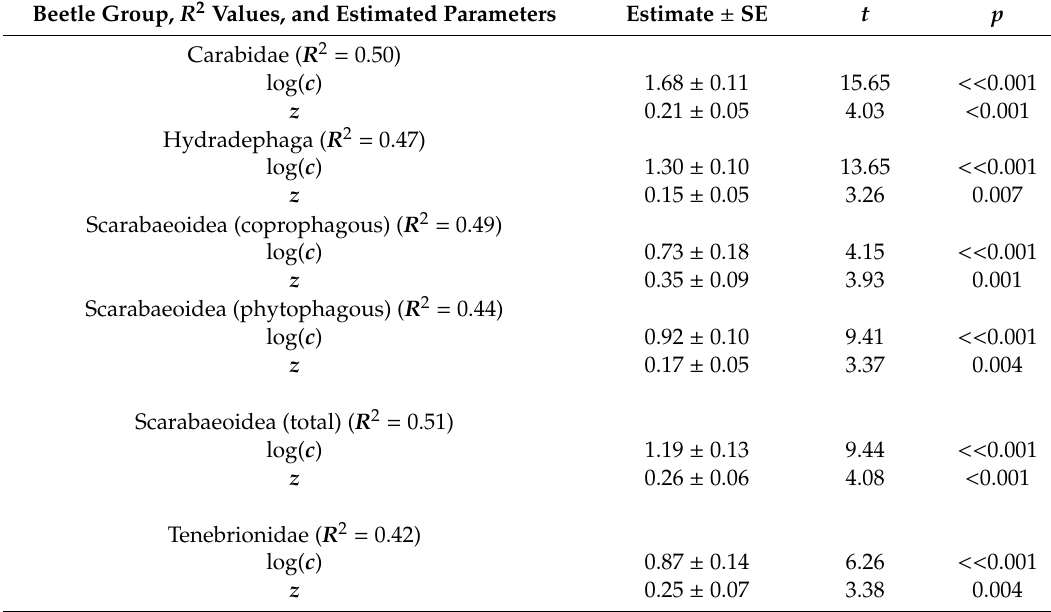
Table 2. Species–area relationships (SARs) for beetles in Italian reserves. SARs were modelled using the linearized version of the power function with decimal logarithms: log( S ) = log( c ) + z log ( A ), where S is the species number, A is area, and c and z are fitting parameters. SE: standard error, t = Student’s t , p = probability, R 2 = goodness of fit.